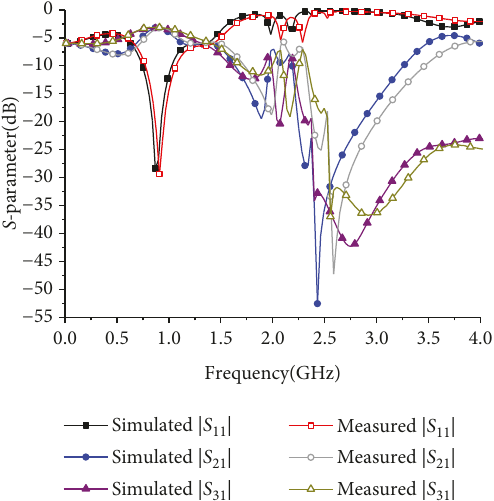
Figure 14: Simulated and measured S